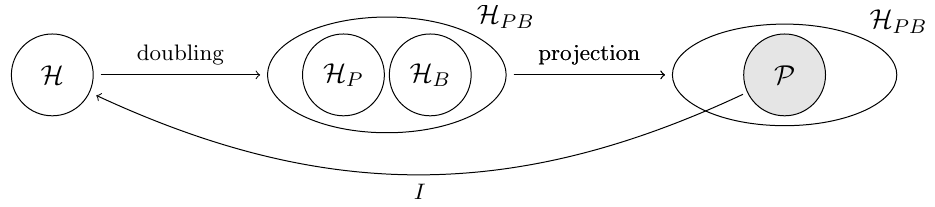
Figure 2: Starting from some Hilbert space to obtain the combined Hilbert space discussed in the main text yields the subspace is restored. Finally, upon acting with I as introduced in Eq. (14), states in identified with states in